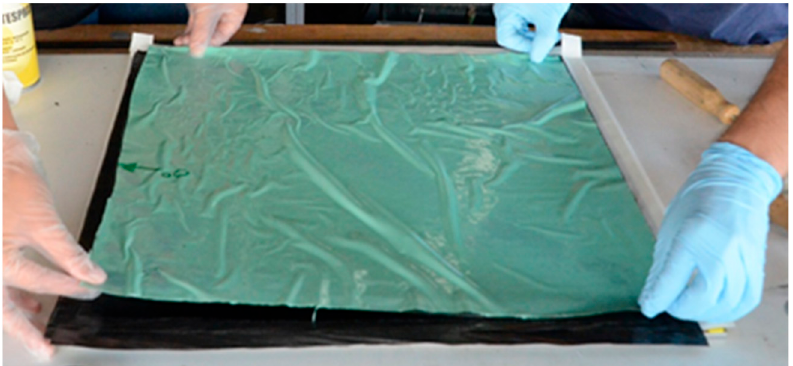
Figure 19. Hand lay-up of the laminate; after curing in a hot-press, specimens are cut from the plate by abrasive water-jet.